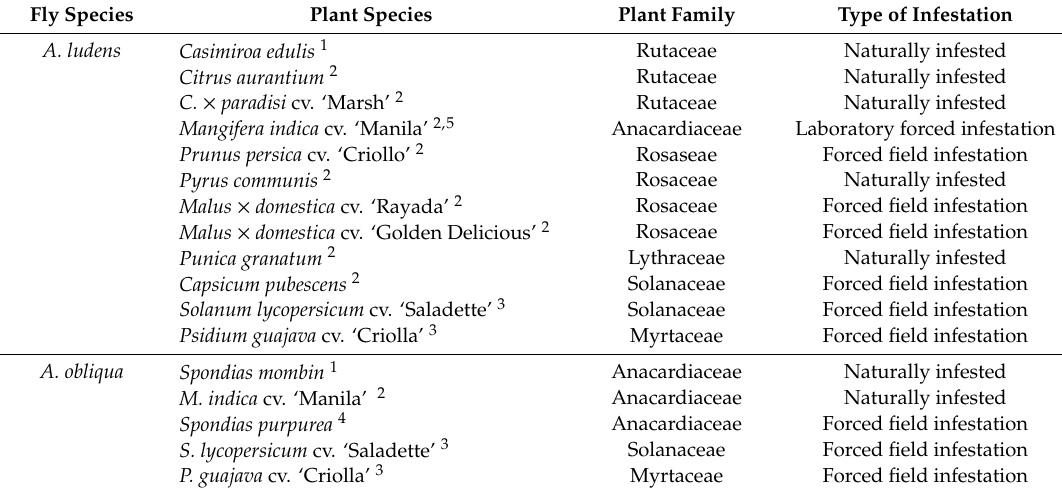
Table 1. Description of treatments and origin of Anastrepha ludens and A. obliqua males used to collect the scent bouquets contained in the e ffl uvia emanating from abdominal pouches and the proctiger of sexually-mature virgin calling